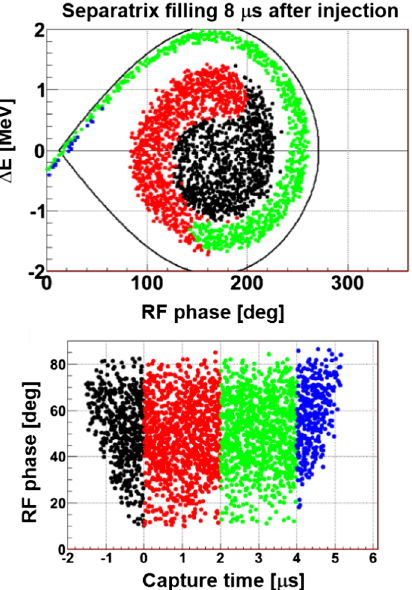
FIG. 11. Filling of the longitudinal separatrix at 3 MeV in S2C2 (top). The accepted rf phases at injection as a function of the relative injection time (bottom). The color codes indicate the link between capture time and position inside the separatrix